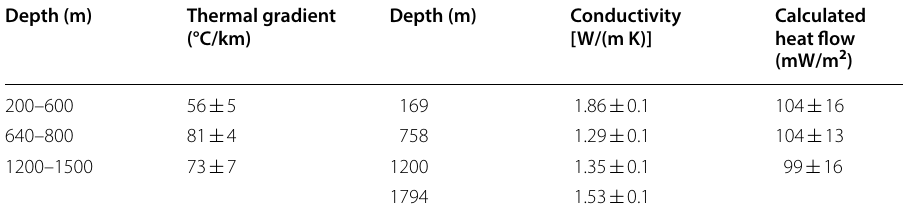
Table 1 Thermal conductivity measurements from core Depth (m)